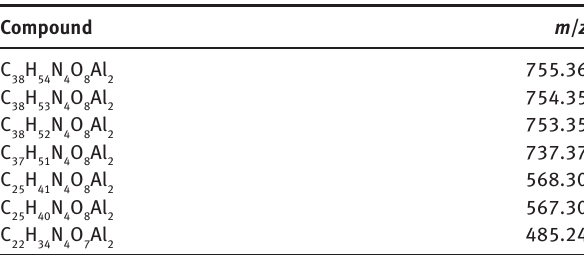
Table 2: FAB mass fragmentation mode of compound